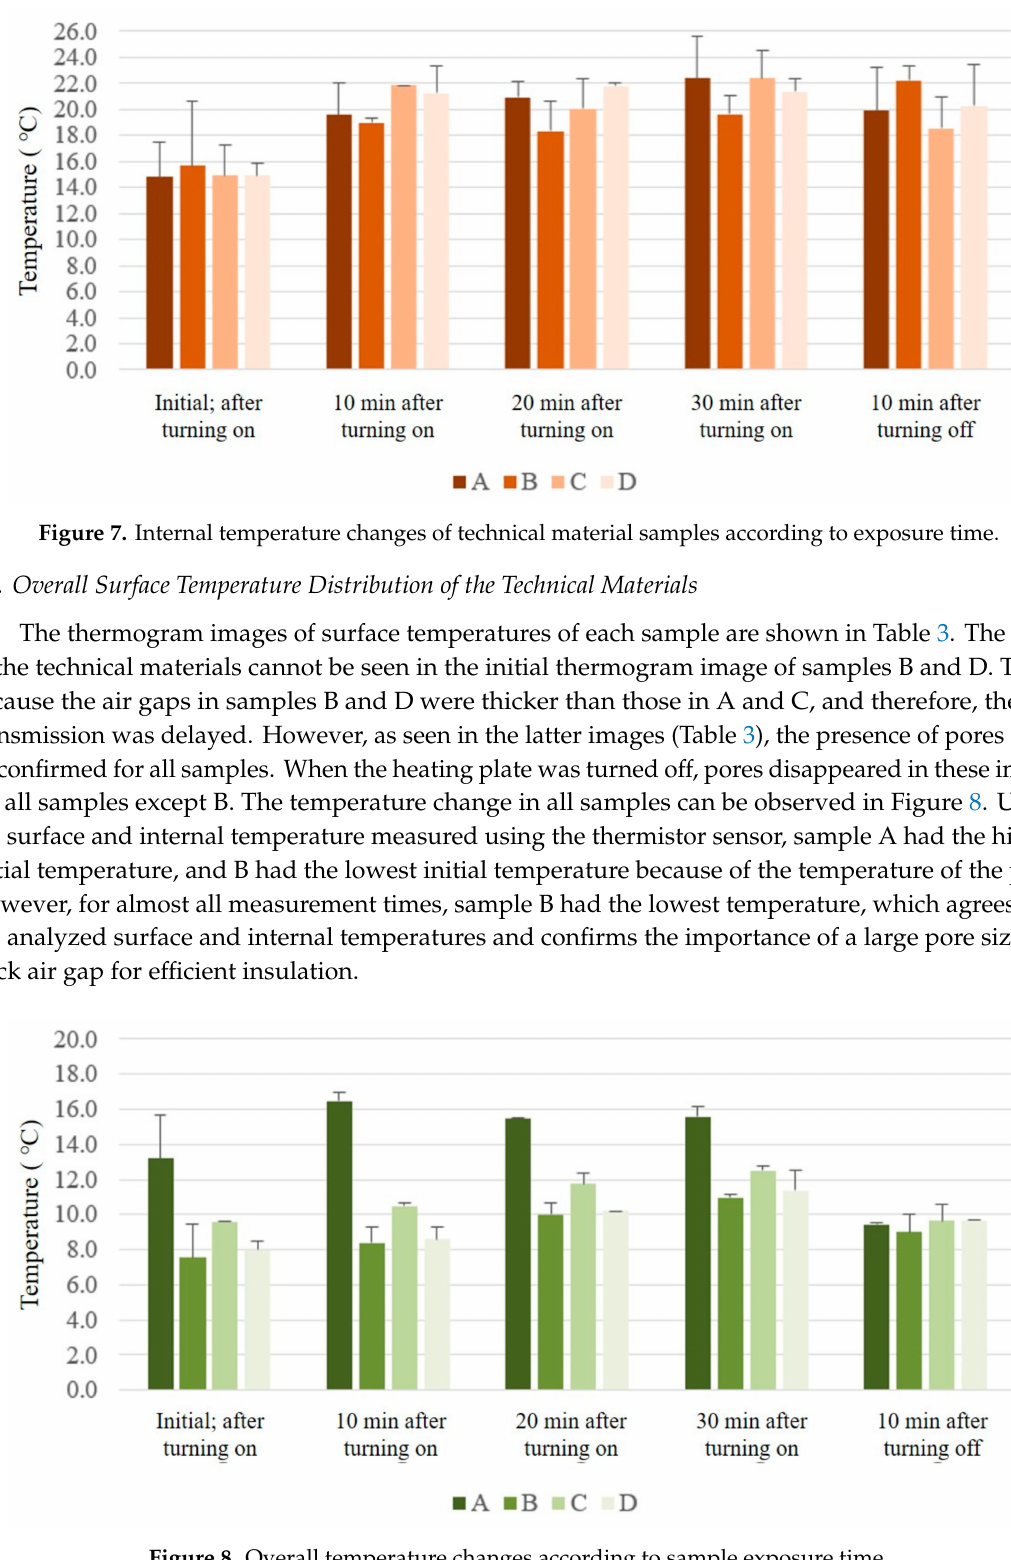
Figure 8. Overall temperature changes according to sample exposure